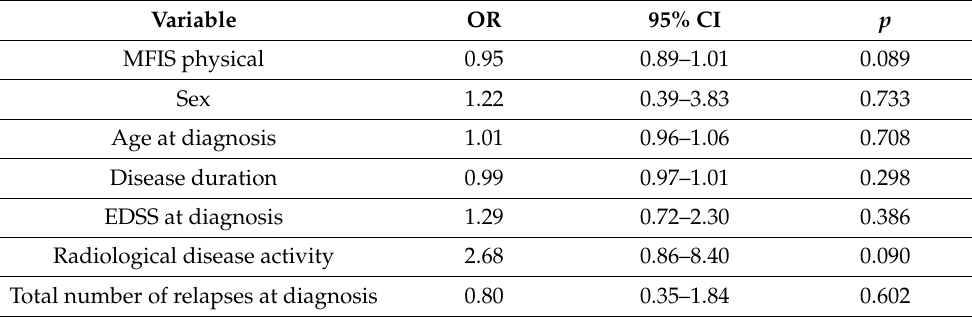
Table 3. Logistic regression analysis of the association of the different MFIS domains and total score, with reaching NEDA-3 in RR-MS patients, after one-year follow-up. Bold values denote statistical